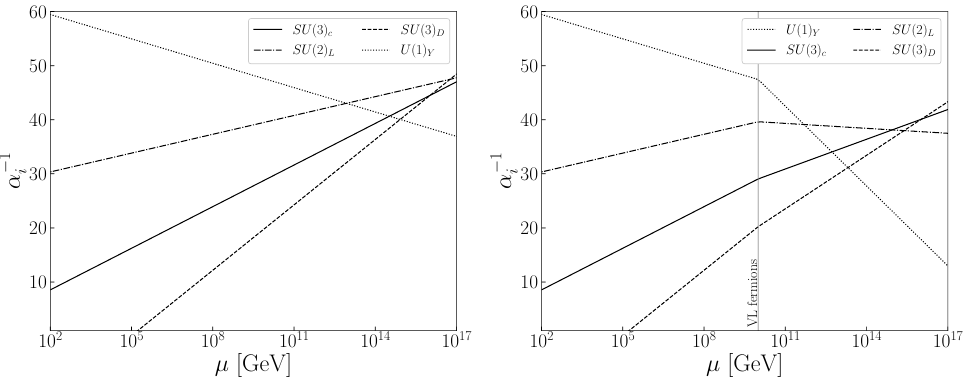
Figure 5 . Running of the gauge couplings in the theory where G dark = SU(3) D unifies with the SM at ∼ 10 15 GeV and confines at ∼ 10 5 GeV. In the left panel we do not include the vectorlike (VL) fermions in the gauge group running, while in the right panel we do, for the indicated VL fermion mass scale. As is typically the case for non-supersymmetric GUTs, the gauge-coupling unification is suggestive but not